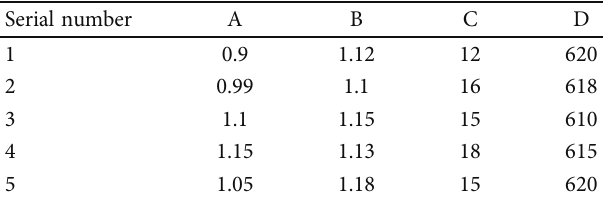
Table 12: Measured input group (F10).